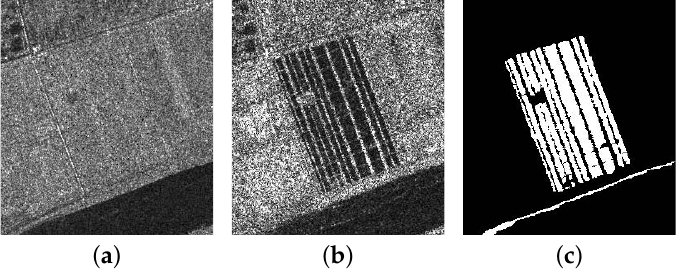
Figure 9. Multitemporal images relating to Farmland D of the Yellow River Estuary and the reference image. ( a ) Image acquired in June 2008. ( b ) Image acquired in June 2009. ( c ) The reference